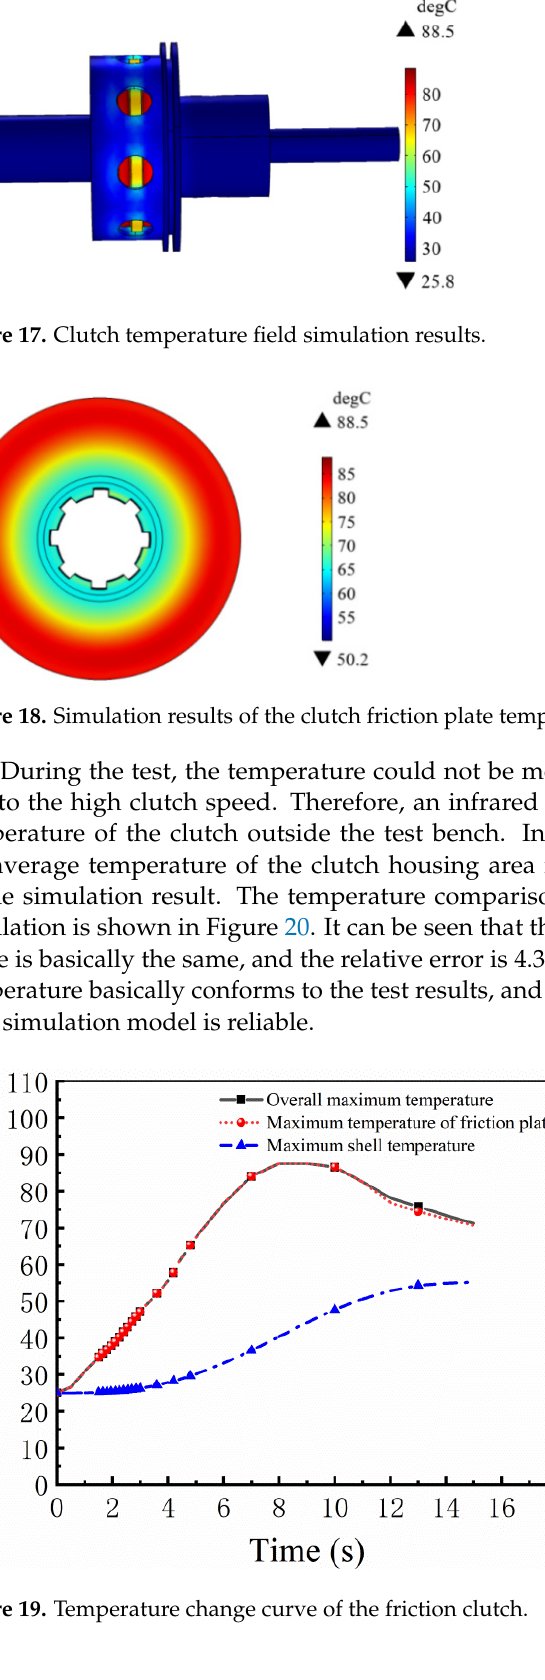
Figure 19. Temperature change curve of the friction clutch.